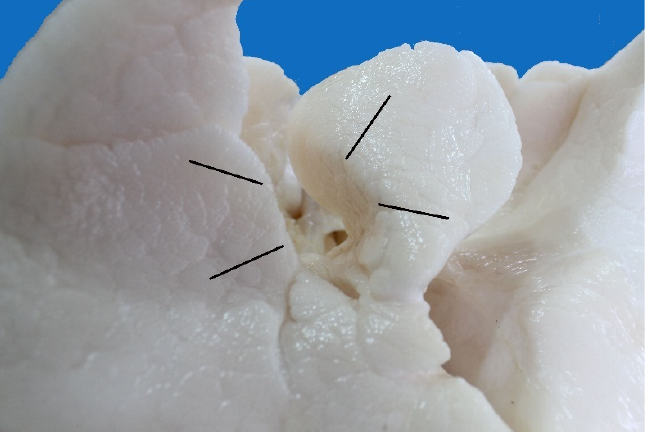
Figure 13. Detail of the groove formed by the accessory lobe for the passage of the caudal vena cava and the right phrenic nerve.